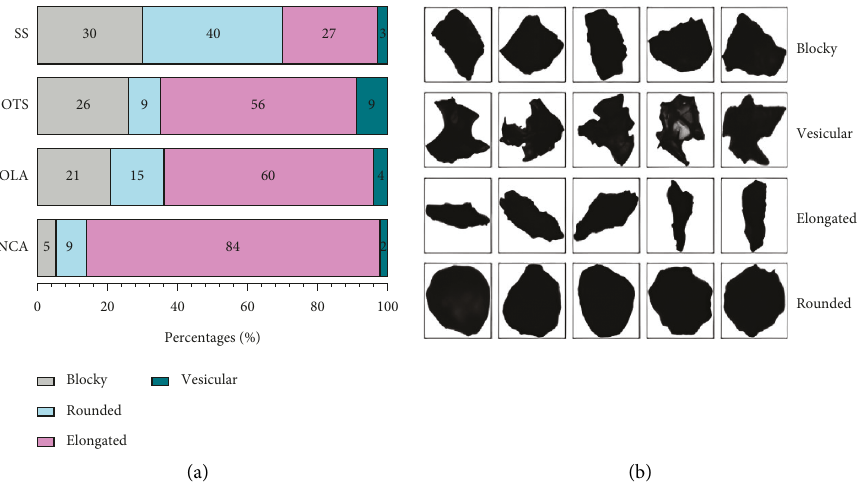
Figure 8: (a) The particle shape classification of the SS, OTS, OLA, and NCA samples. (b) The particle shape morphology shows blocky, vesicular, elongated, and rounded shapes